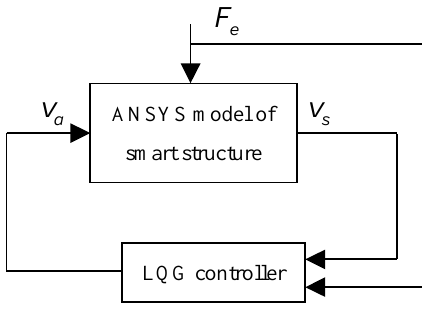
Fig. 2. Block diagram of the closed-loop